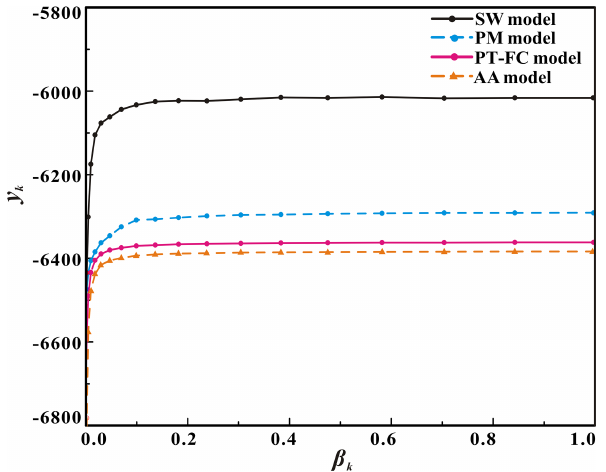
Figure 5. Variation of the mean posterior expectation of the poten- tial y k with β k for the PM, SW, PT–FC, and AA